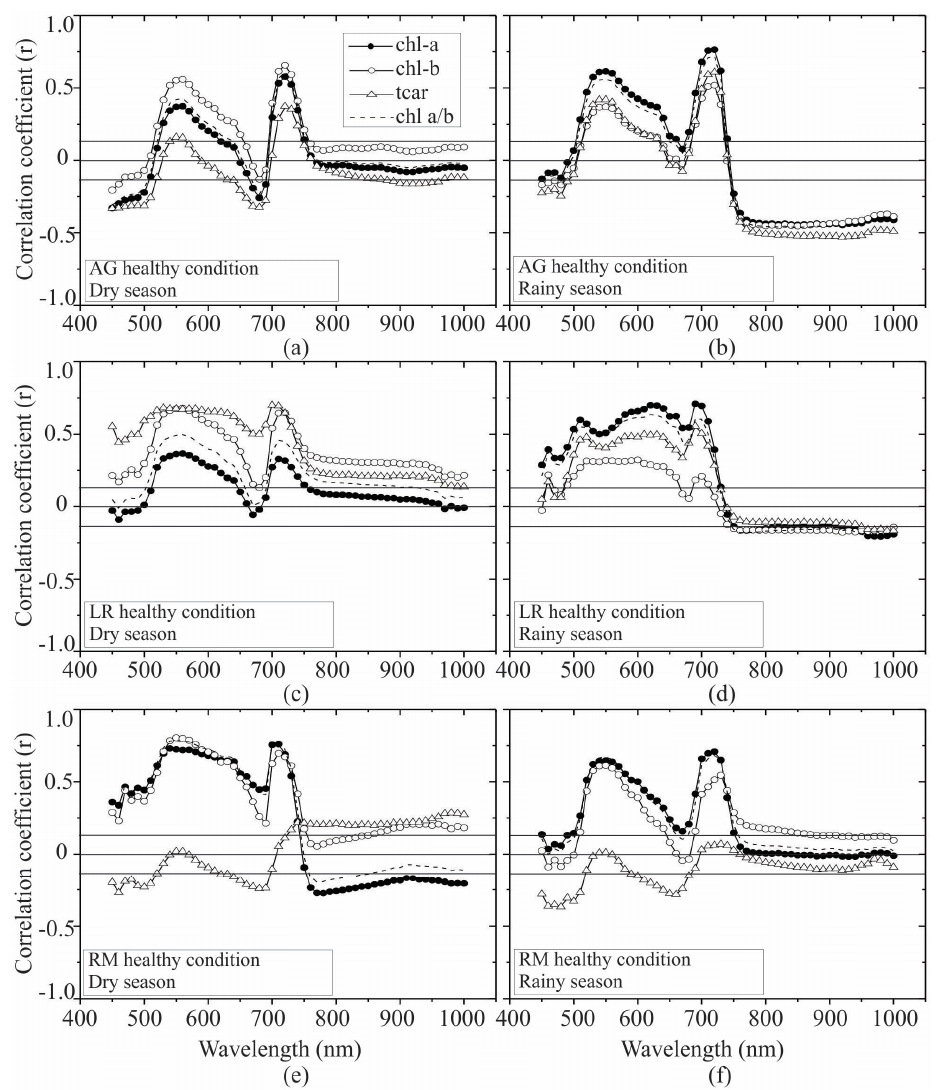
Figure 6. Correlograms of leaf pigments and pseudo-absorption of mangroves under healthy condition for the dry and rainy seasons. Avicennia germinans (AG), Laguncularia racemosa (LR), and Rhizophora mangle (RM). The horizontal lines at ±0.12 correlation indicate the 95% confidence limit. ( a ) AG dry season, ( b ) AG rainy season; ( c ) LR dry season; ( d ) LR rainy season; ( e ) RM dry season; ( f ) RM rainy season. 3.3. Estimation of Chlorophyll-a, Chlorophyll-b, and Total Carotenoids Contents Based on Selected Vegetation Indices. Table 3. Regression analysis of vegetation indices with leaf pigment chlorophyll-a, chlorophyll-b, and